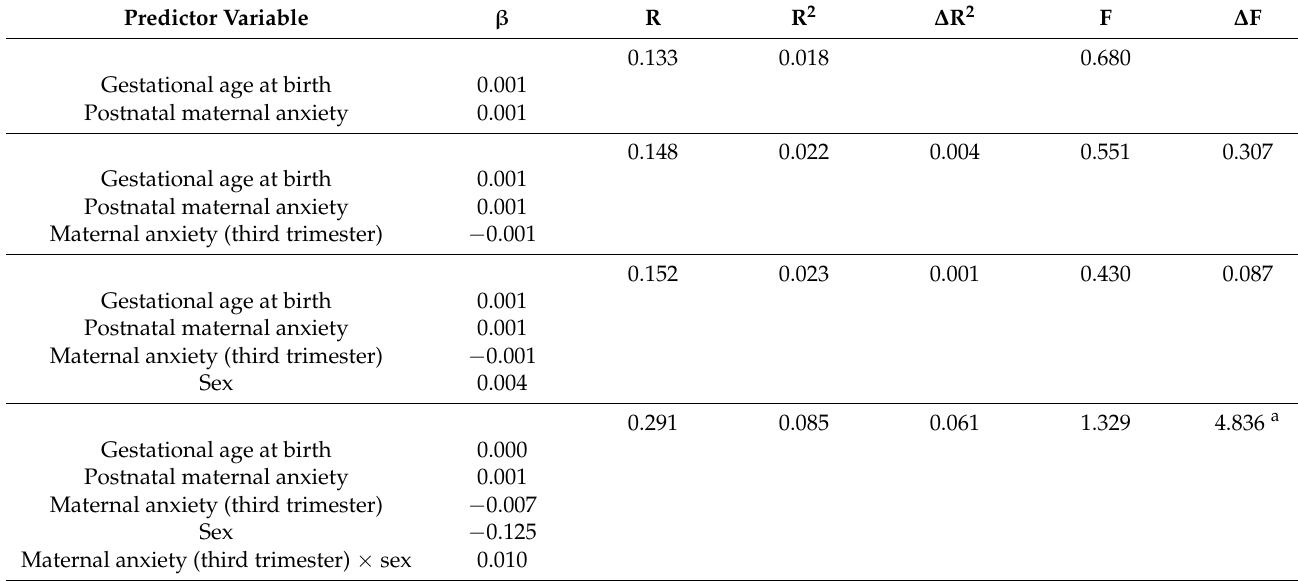
Table 4. Linear regression model of methylation level of IGF2/H19